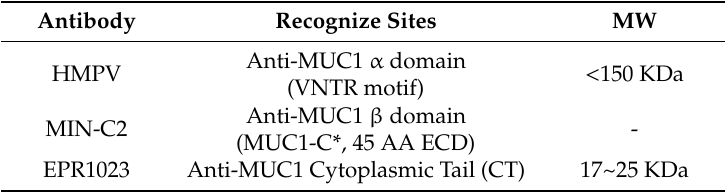
Table 1. Antibody recognition for MUC1 of each